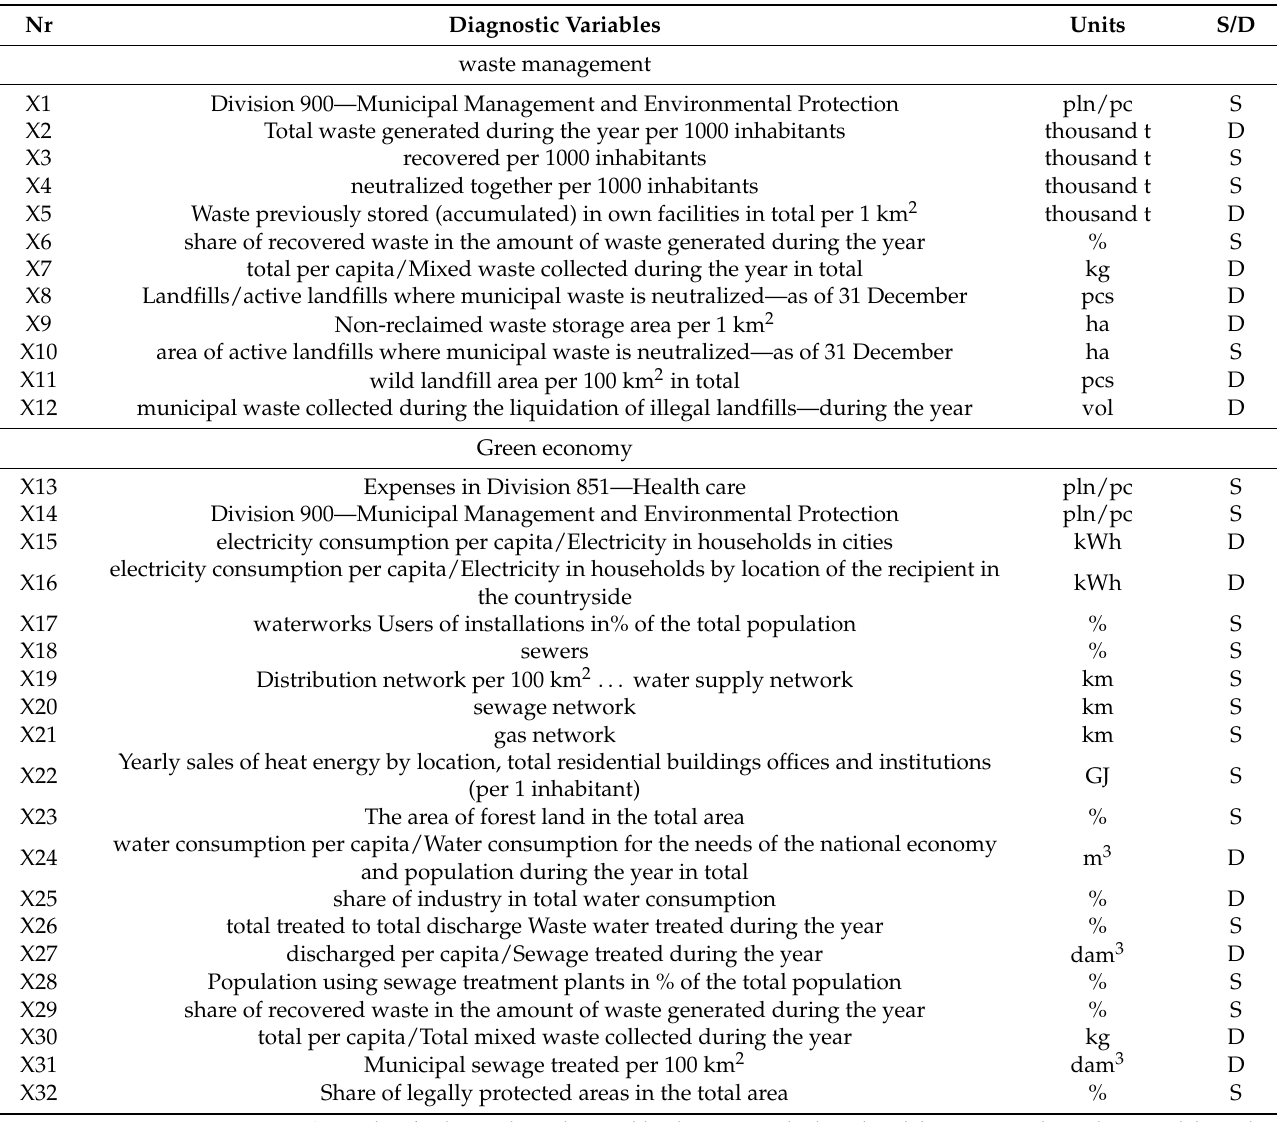
Table 2. Describing variables—sustainable development, waste